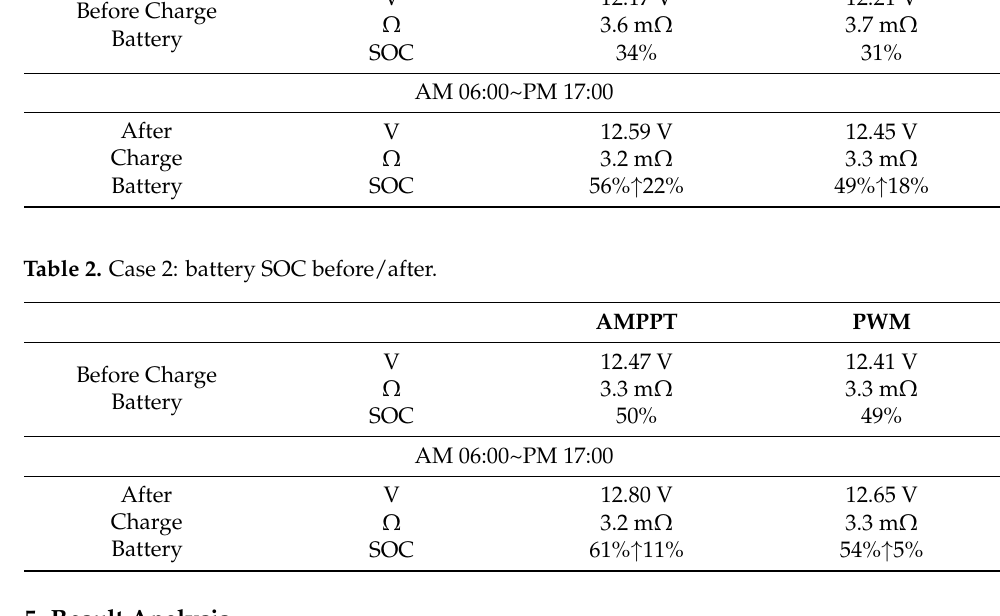
Figure 10c confirms that the integrator operated from 7:20 am to 8:10 am and from 4:12 pm to 5:22 pm, when power was generated insufficiently due to the weak